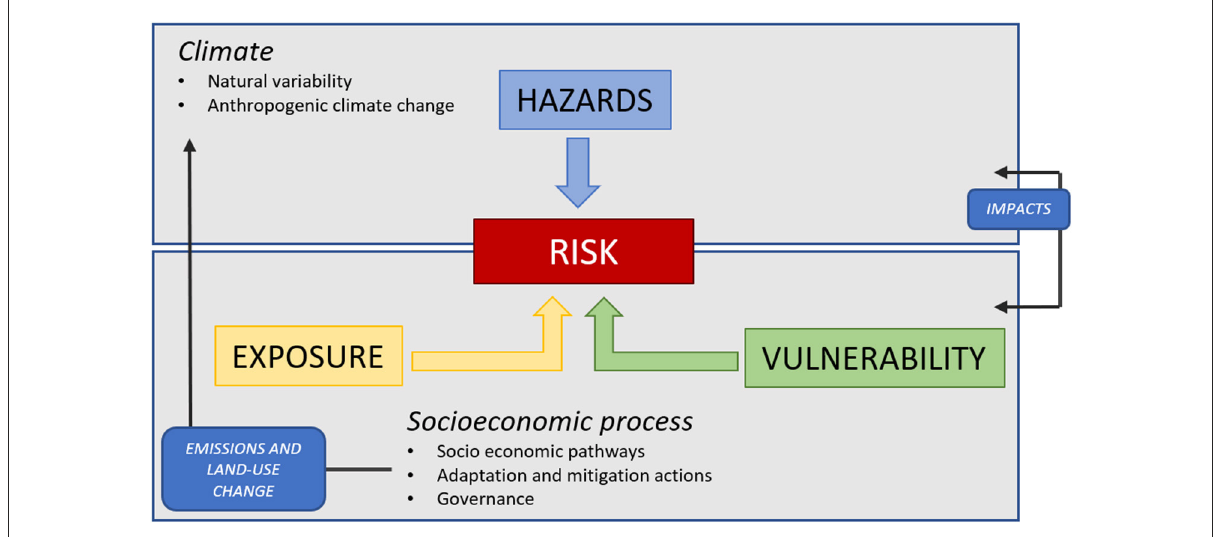
FIGURE1 Illustration of the core concepts of the IPCC WGII AR5. The risk of climate-related impacts results from the interaction of climate-related hazards (including hazardous events and trends) with the vulnerability and exposure of human and natural